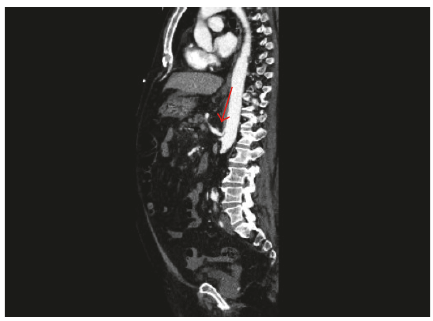
Figure 2: Evidence of celiac trunk stenosis : Sagittal reconstruction of contrast-enhanced CT scan of abdomen revealing the evidence of stenosis at the take-off of the celiac trunk (Arrow).